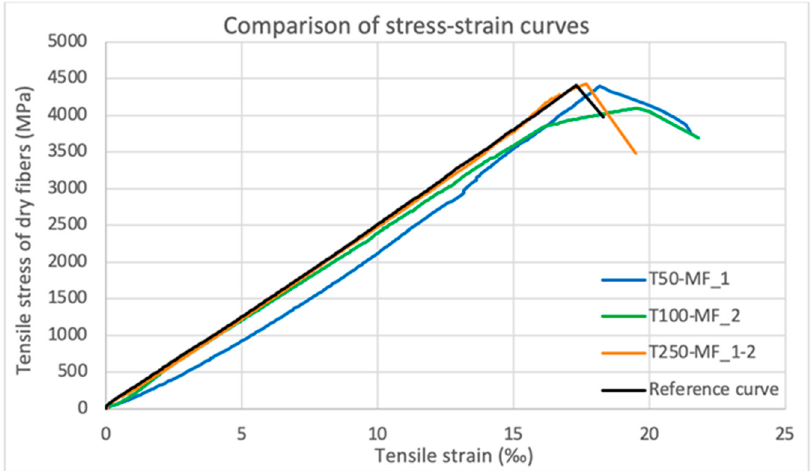
Figure 16. Stress–strain curves of monotonic, uniaxial tensile tests after exposure to the temperatures of 50, 100 and 250 °C and then cooling.